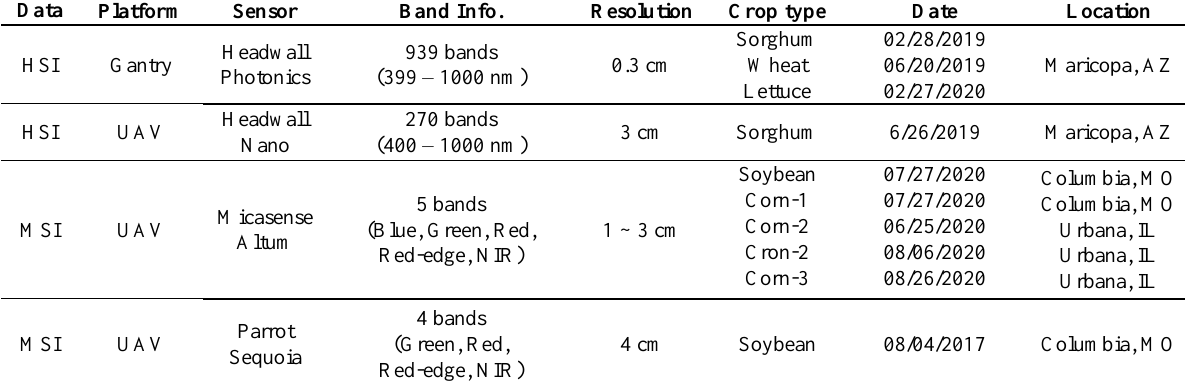
Table 1 List of remote sensing platforms, sensors and corresponding datasets